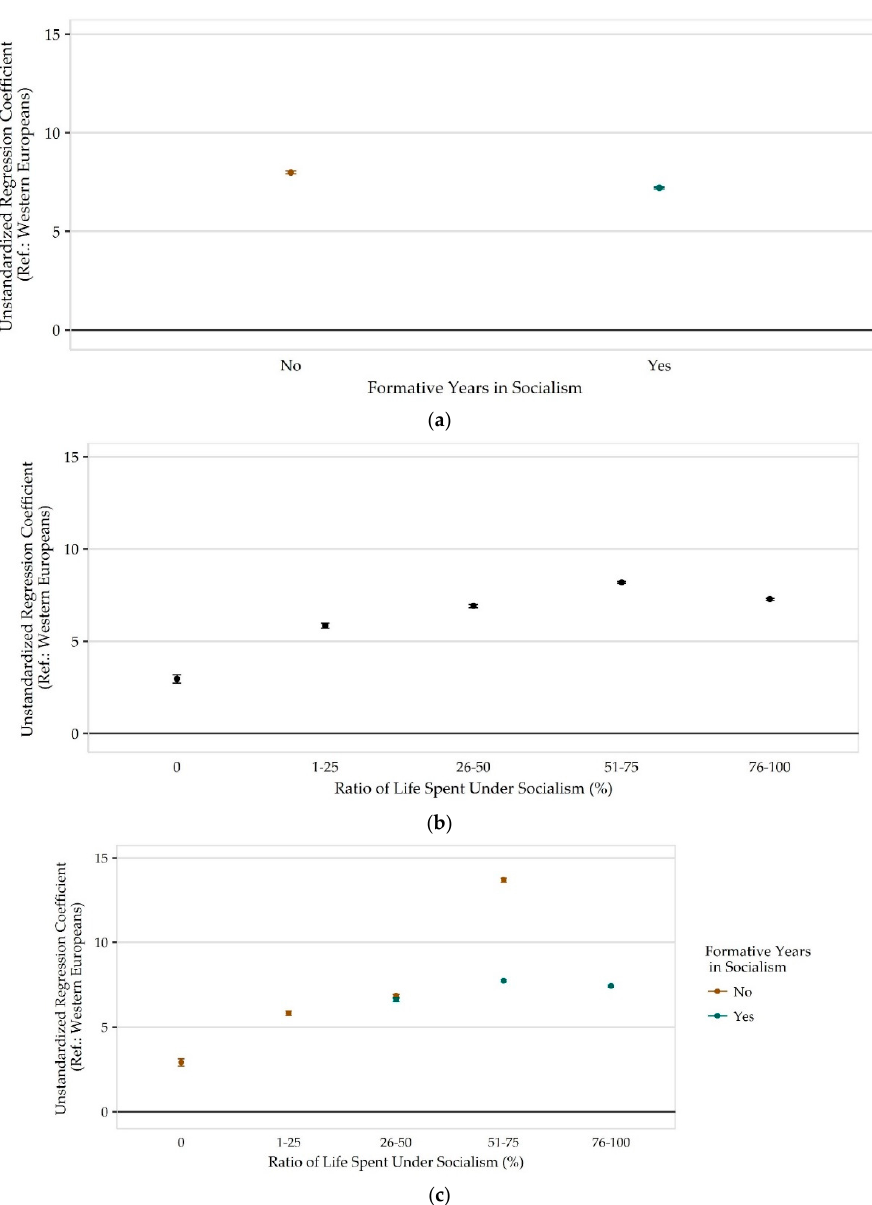
Figure 6. Value of (unstandardized) regression coefficients of “Post-socialist” country dummy for explaining perceived subjective Gini: ( a ) Respondents divided by their formative year; ( b ) Respondents divided by their exposure rate; ( c ) Respondents divided by their formative years and their exposure rate. Notes : ISSP, own calculations. Marginal effects with 95% confidence interval from bootstrapped OLS regressions. For corresponding models and analysis see Tables A10–A12 in Appendix D.